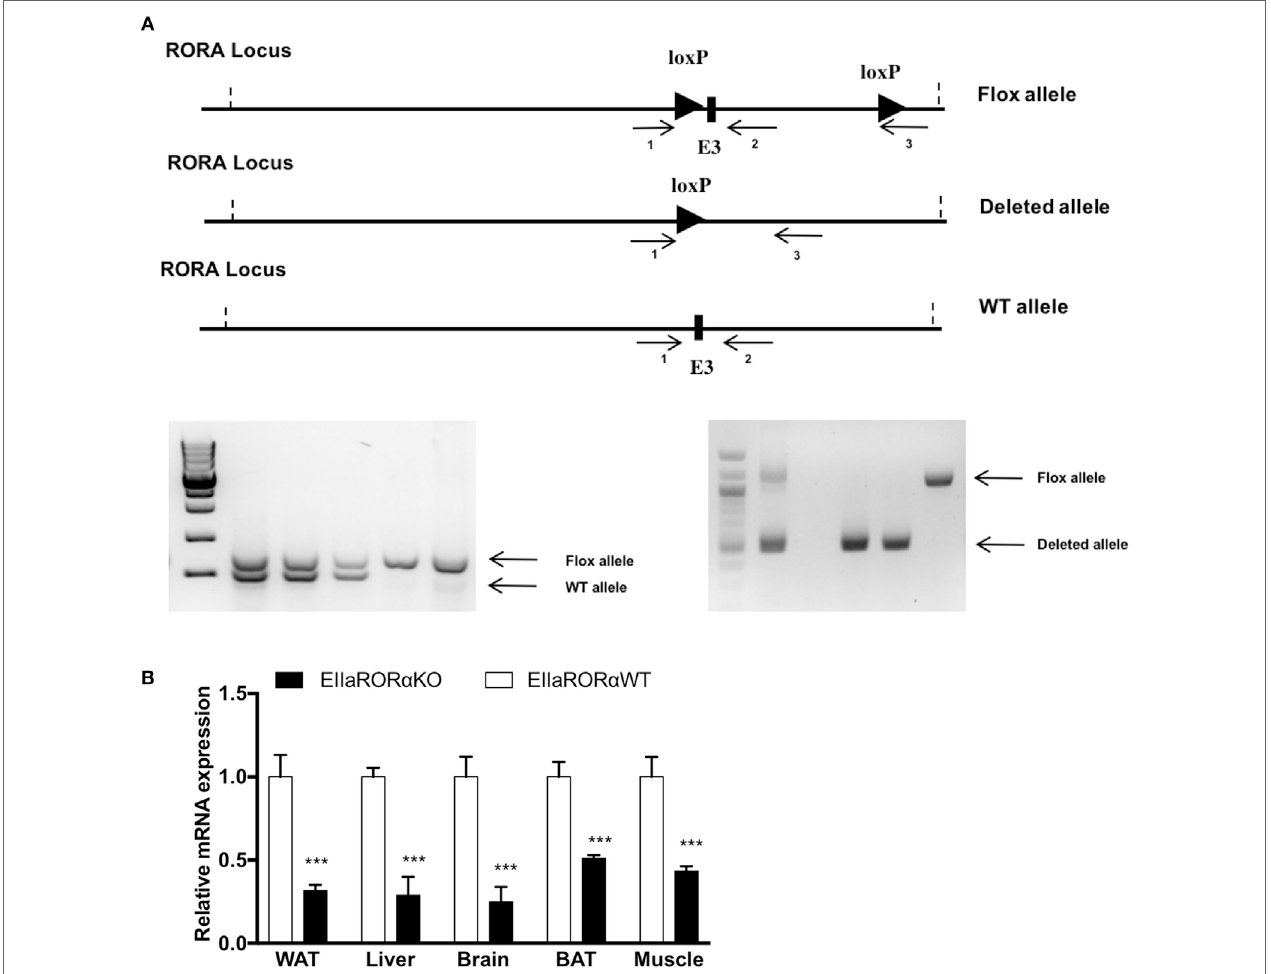
FigUre 1 | ROR α flox loci construct and validation of ROR α deletion. (a) Schematic representation of the LoxP sequence in ROR α loci and primer localization. To assess the presence of the LoxP sites and the deleted allele after action of the cre recombinase, two sets of primers were designed (1–2 and 1–3). 1.5%-Agarose gel representing the genotyping results after PCR amplification. The WT and Flox alleles were amplified with the set of primer 1–3, and the deleted allele was amplified with the set of primers 1–3. (B) White adipose tissue (WAT), liver, brain, brown adipose tissue (BAT), and muscle gene expression for ROR α from 2-month-old EIIAROR α WT (white bar, n = 6) and EIIAROR α KO (black bar, n = 6) (*** p <